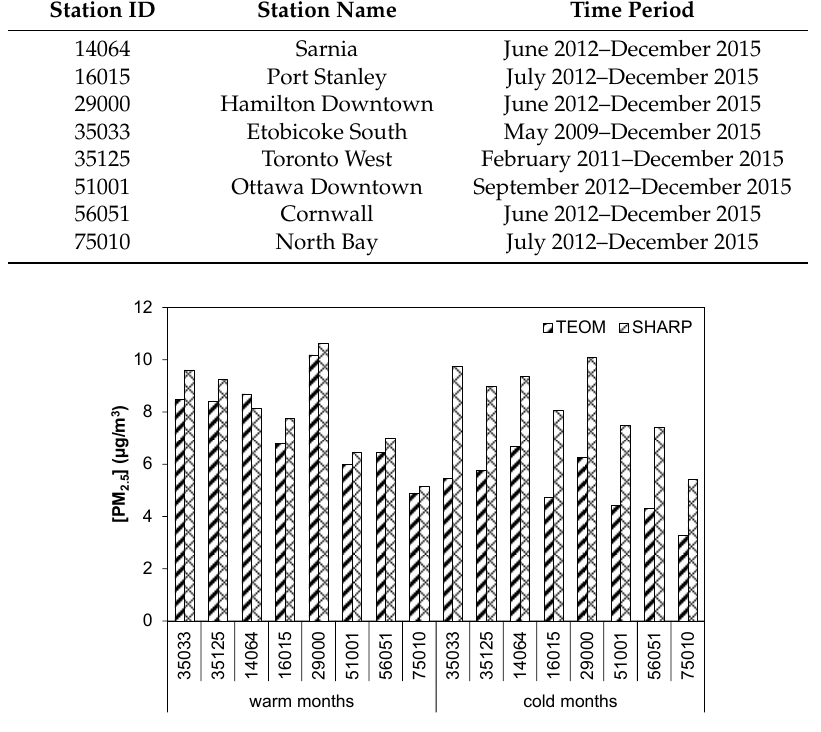
Figure 7. PM 2.5 average concentrations in warm months (May–September) and cold months (October–April) at eight stations.